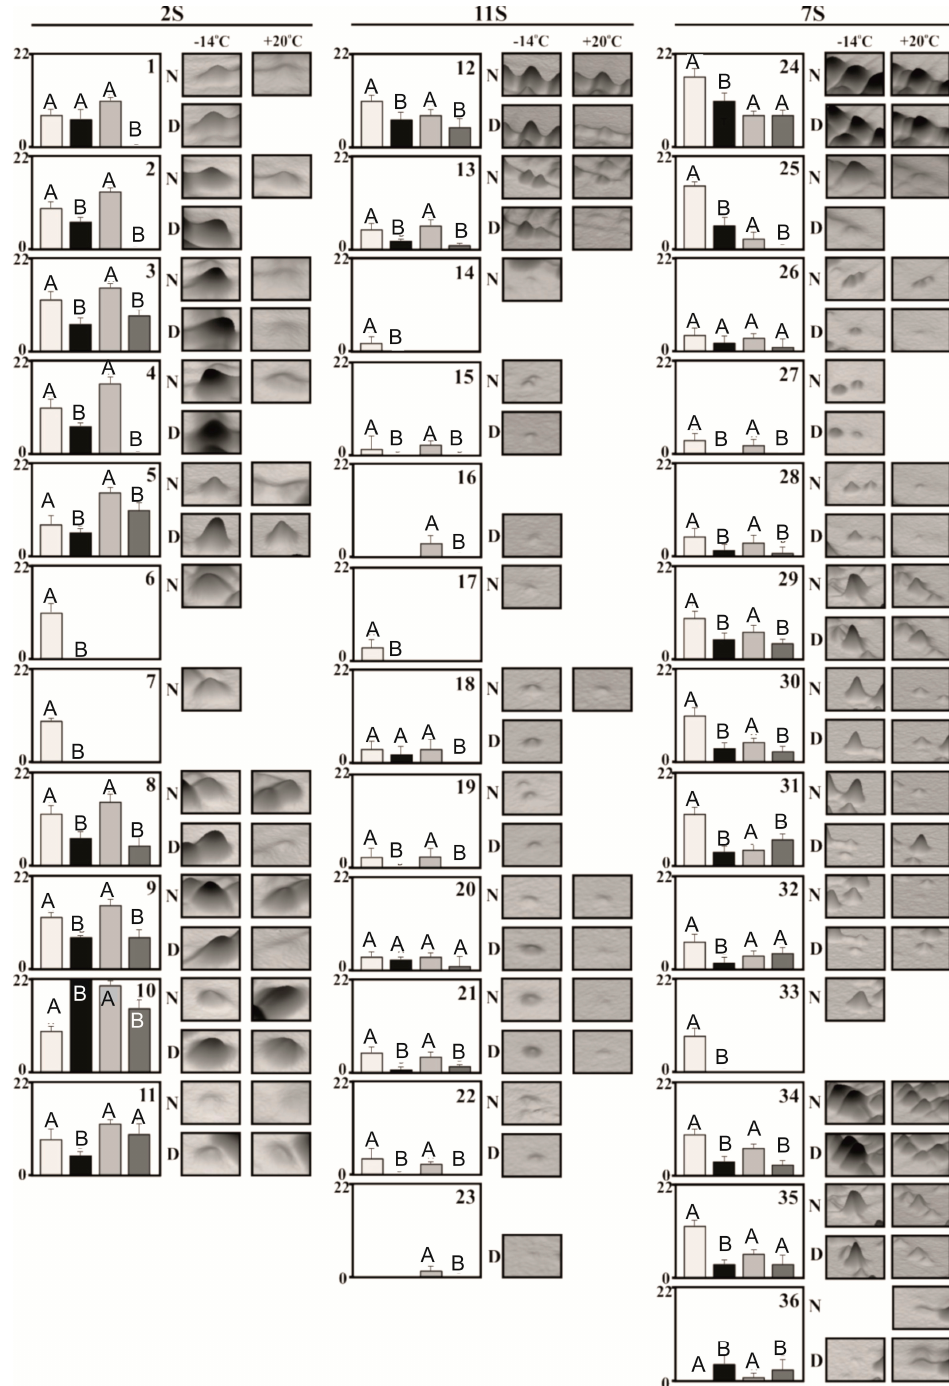
Figure 8. Comparison of the intensities of identified proteins (left hand panel for each fraction, albumin, vicilin, and legumin) and the three-dimensional (3-D) visualization of electrophoretic spots (right hand panel). The numbers given in each graph within the left hand panel are the numerals of identified proteins for each seed lot: Nadwi´sla´nski − 14 ◦ C (cid:3) ; Nadwi´sla´nski + 20 ◦ C (cid:4) ; Dino − 14 ◦ C (cid:4) ; Dino + 20 ◦ C (cid:4) . Data for storage temperature variants designated with the same capital letter are not significantly di ff erent ( p ≤ 0.05, Tukey’s test); means labelled with di ff erent capital letters are significantly di ff erent among the described groups; bars denote standard deviation of the